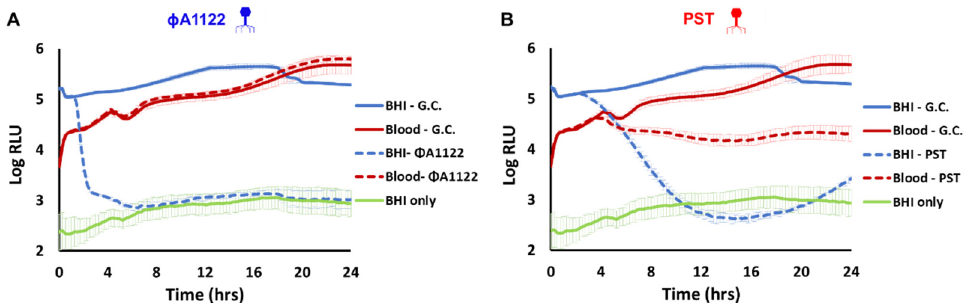
Figure 4. PST is more potent than ф A1122 in the presence of blood. Phage-based lysis assays were performed with the bioluminescent Y. pestis strain EV76-lux (10 7 CFU/mL) suspended in BHI broth (blue and orange lines) or in mouse whole blood (gray and red lines). The Y. pestis strain was infected with ф A1122 (A) or PST (B) phages (10 6 PFU/mL; multiplicity of infection (MOI) = 0.01). Bioluminescence (RLU) was measured at 37 °C in 15 min intervals for 24 h using a SPARK 10M plate reader. The experiment was performed in biological duplicates (using blood pooled from three mice for each experiment), and the results are representative of one experiment. Presented values are the average results from three wells in a single triplicate experiment, and the error bars represent the standard deviations (SD). The green line represents the background from BHI broth. G.C. = growth control.